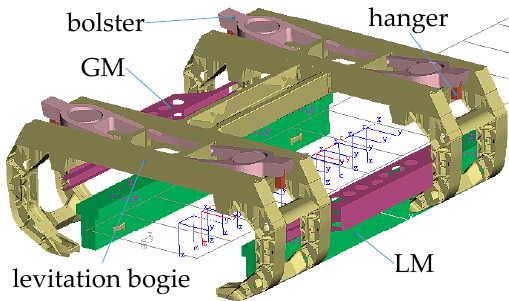
Figure 2. Flexible body dynamic model of the levitation bogie and the LM.